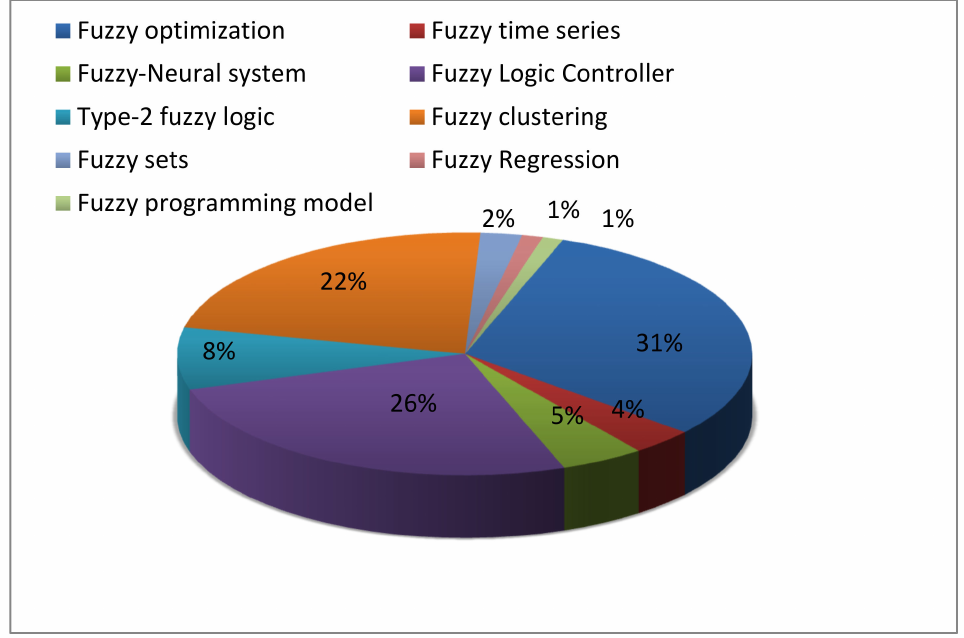
Figure 9. Distribution of FL models in combination with the HS algorithm (2007~22 August